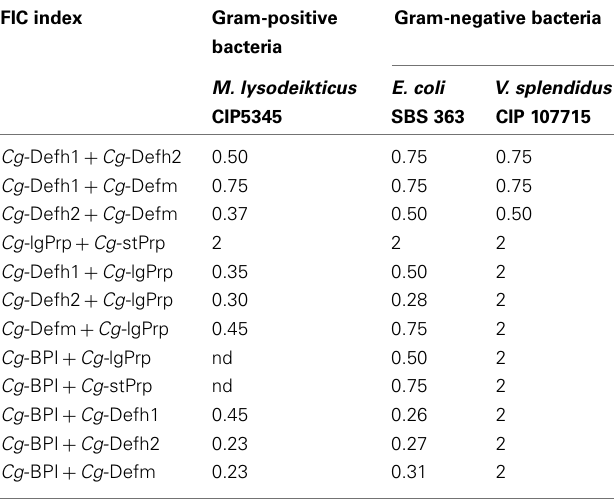
Table 3 | Synergistic activities between Cg -Defs, Cg -Prps, and Cg -BPI against selected bacteria expressed as a fractional inhibitory concentration (FIC